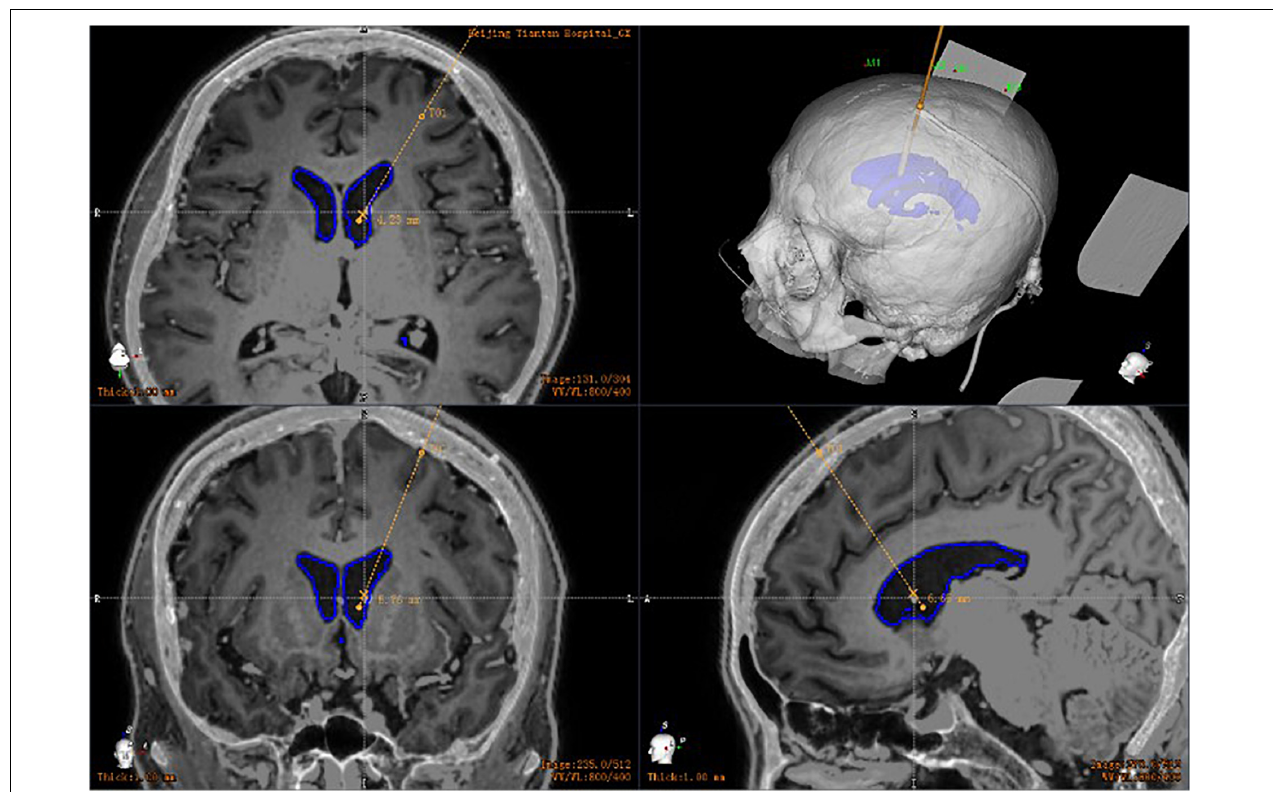
FIGURE 4 | Postoperative drainage tube reconstruction: postoperative image fusion, 3D reconstruction of the position of the intracranial drainage tube; the drainage tube is accurately implanted into the ventricle.